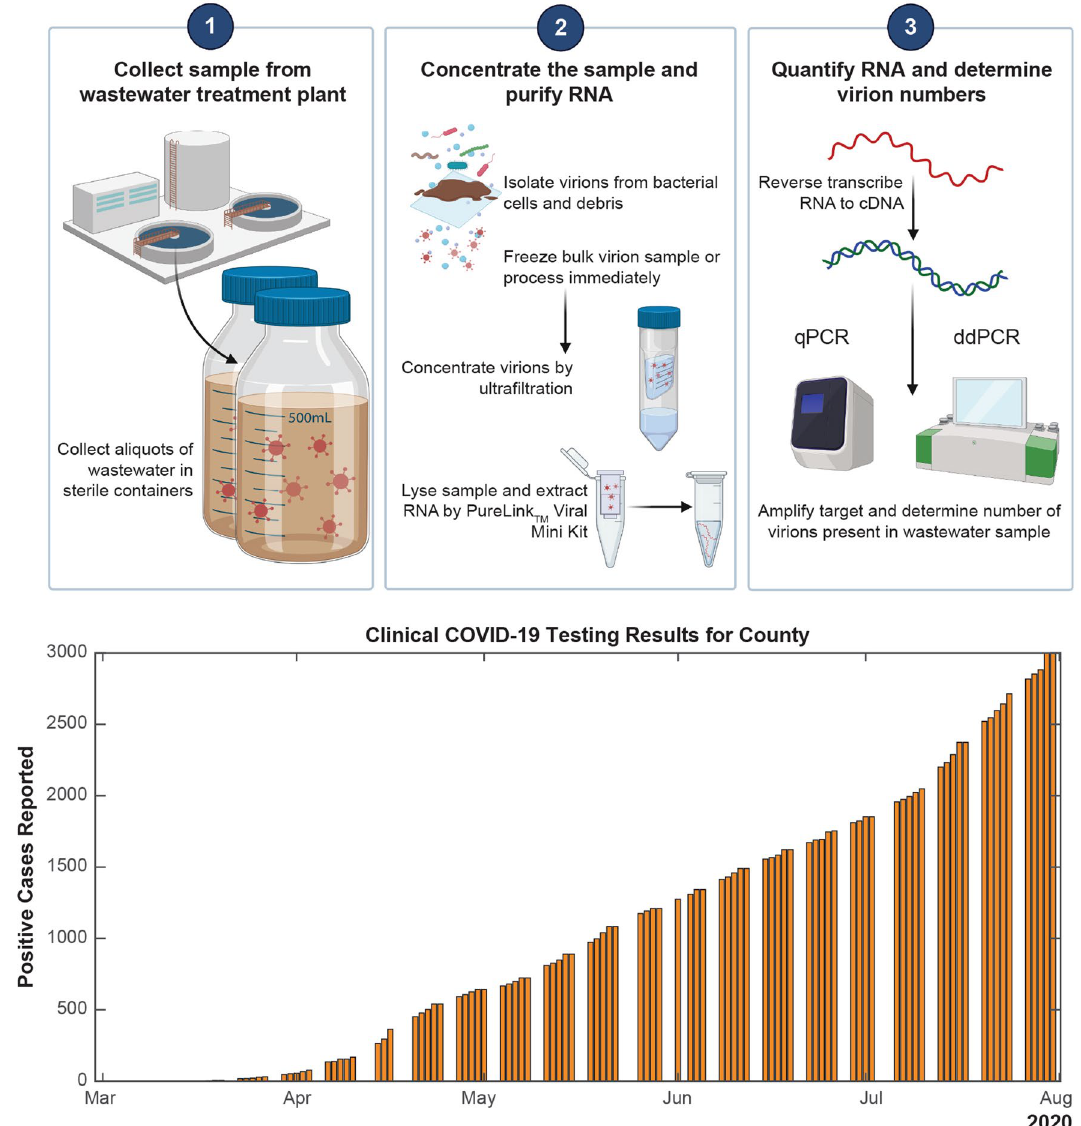
Figure 1. Wastewater-based monitoring for community-level COVID-19 tracking. Top: Workflow for sample collection through detection and quantification of SARS-CoV-2 using both quantitative and droplet digital PCR platforms (created with BioRender.com). Bottom: County health department data for positive cases reported by clinical testing within the county that encompasses the wastewater treatment plant (sampling site) in the date range relevant to sample collection 30